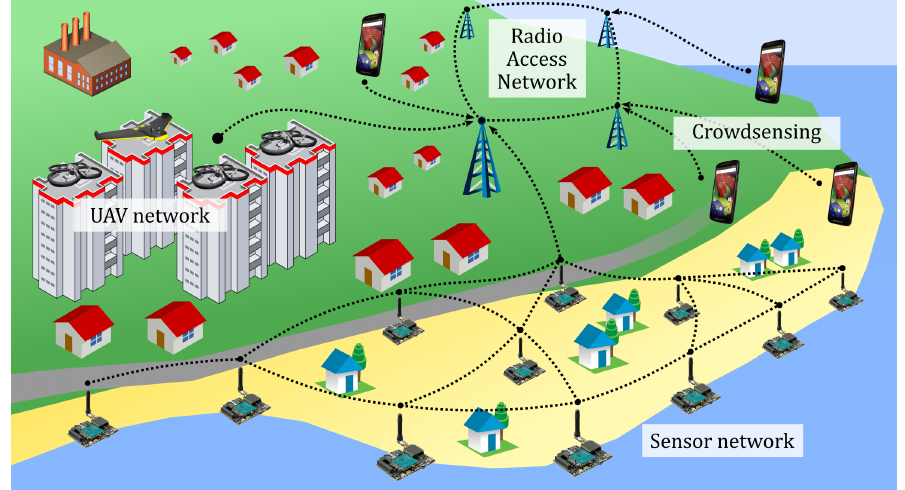
Figure 1. Overall IMATISSE